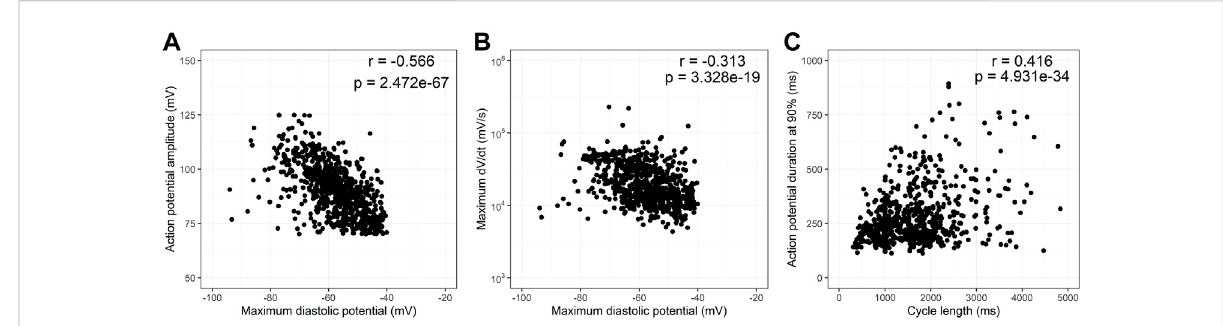
Correlation of action potential variables. Scatter plots of action potential amplitudes (APA) and maximum dV/dt (dV/dt max) as a function of maximum diastolic potential (MDP) are shown in (A,B) , respectively. (C) shows a scatter plot of action potential duration at 90% repolarization (APD90) as a function of cycle length. All correlations are statistically signi fi cant although correlation coef fi cients are low. Heteroscedasticity increases with cycle length especially above 2,000 ms.